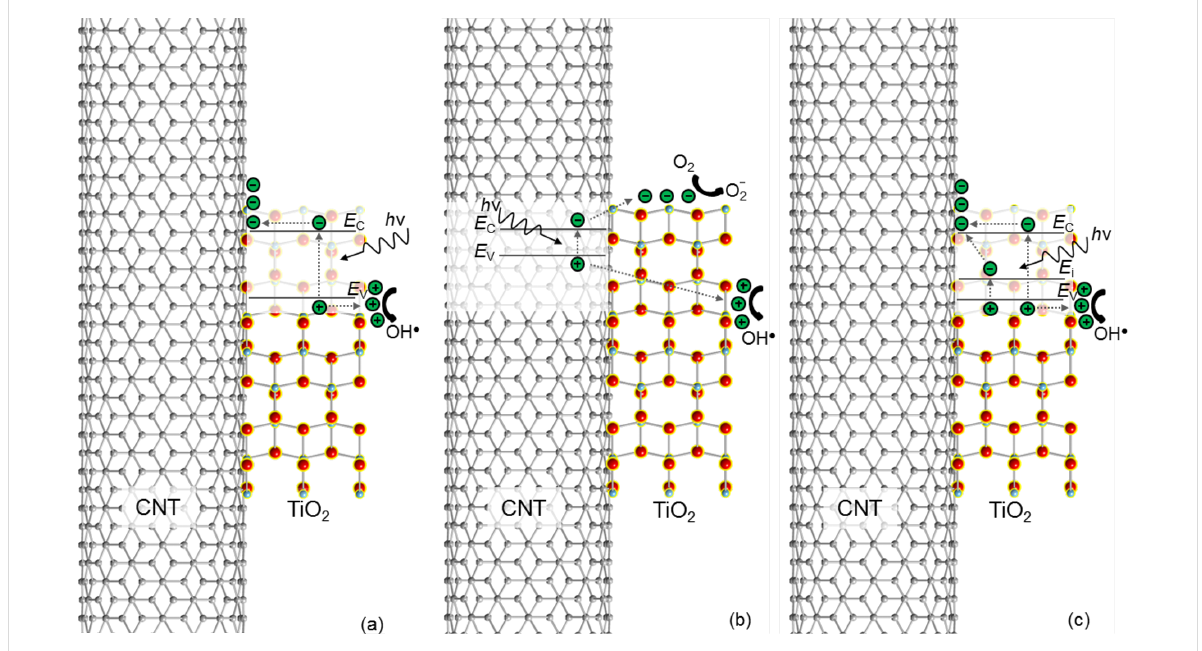
Figure 1: Efficiency enhancement mechanisms for photocatalysis using CNT–TiO 2 nanocomposites. (a) CNT scavenges electrons generated in TiO 2 , resulting in excessive holes on the surface for redox actions. (b) CNT acts as a photosensitizer and injects electrons and holes into TiO 2 for redox actions. (c) CNT introduces energy states in the band gap of TiO 2 which can convert long wavelength photons to electrons and holes. Adapted from [18]. Copyright (2009) WILEY-VCH Verlag GmbH & Co. KGaA,